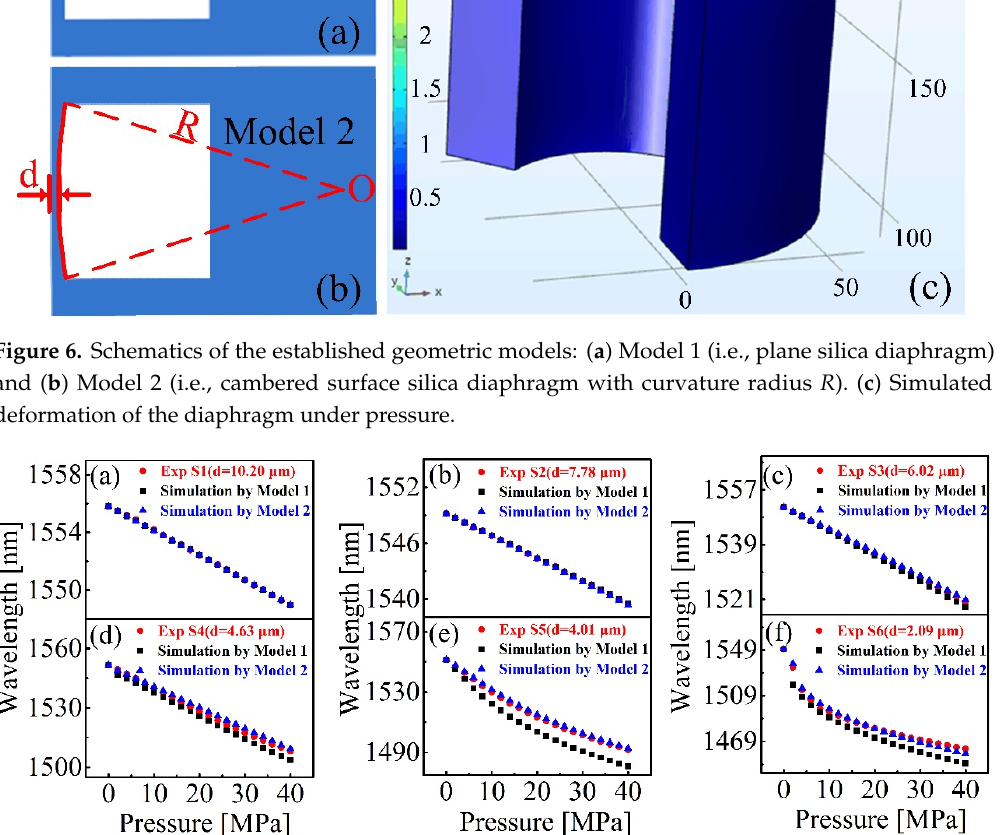
Figure 7. Experimental (red dots) and calculation results of the six sensor samples: ( a ) S1 ( d = 10.20 μ m), ( b ) S2 ( d = 7.78 μ m), ( c ) S3 ( d = 6.02 μ m), ( d ) S4 ( d = 4.63 μ m), ( e ) S5 ( d = 4.01 μ m), and ( f ) S6 ( d = 2.09 μ m). (The black square dots denote the calculation results by Model 1 and the blue triangle dots represent the calculation results by Model 2 with curvature radius of 400 μ m.)